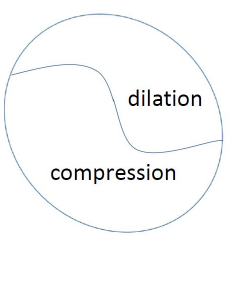
Figure 1: det, per, and d H χ on C